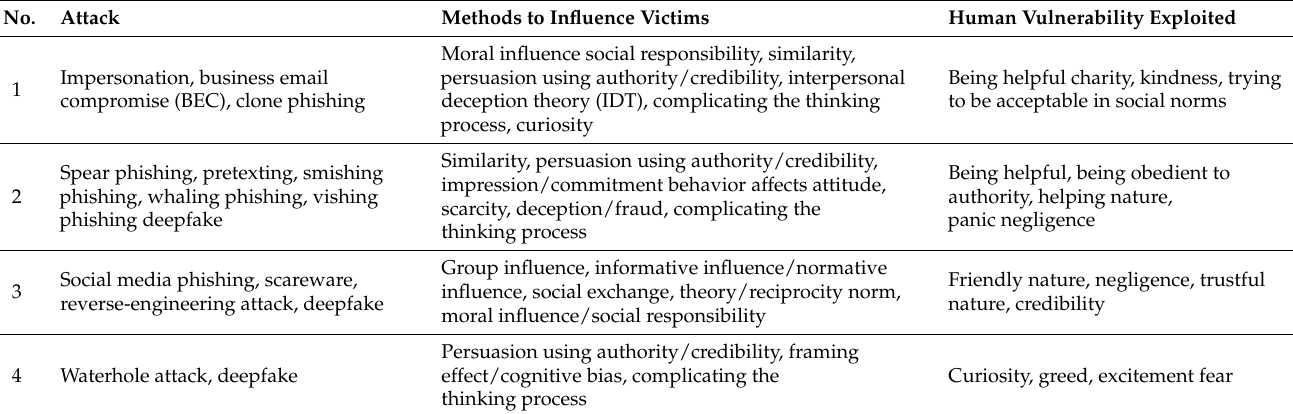
Table 8. Association between social engineering-based cyberattacks, method of influence, and human